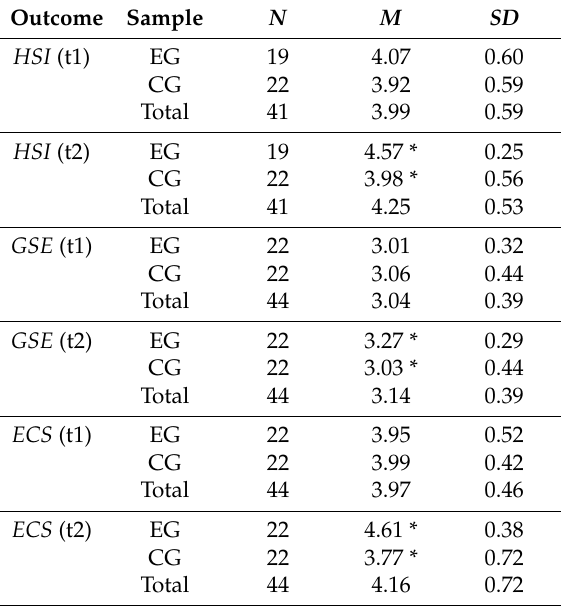
Table 2. Means and standard deviations (SD) in experimental group (EG) and control group (CG) at both data collection